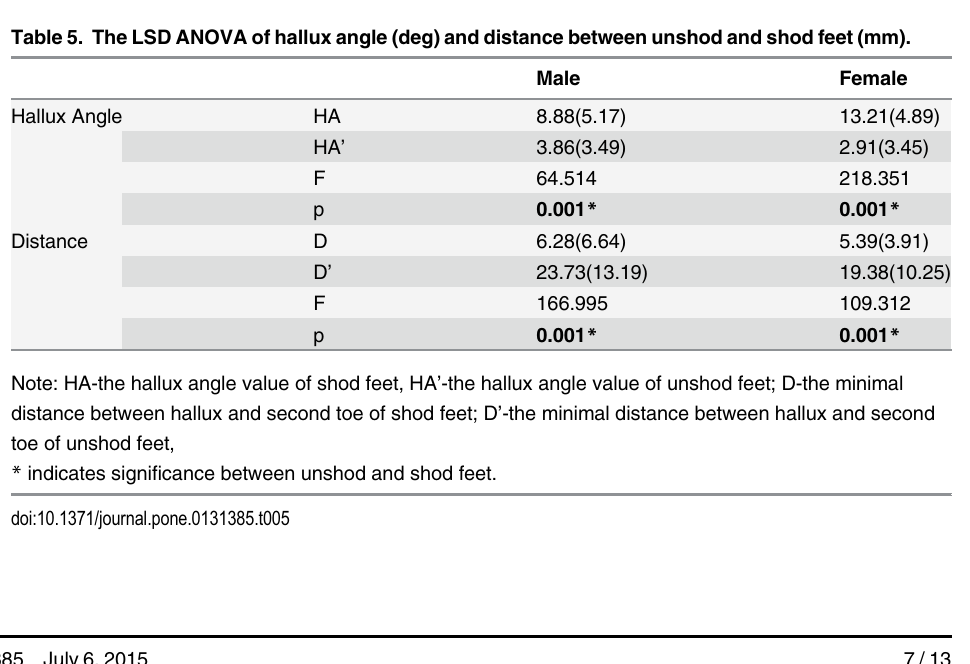
Table 5. The LSD ANOVA of hallux angle (deg) and distance between unshod and shod feet (mm).